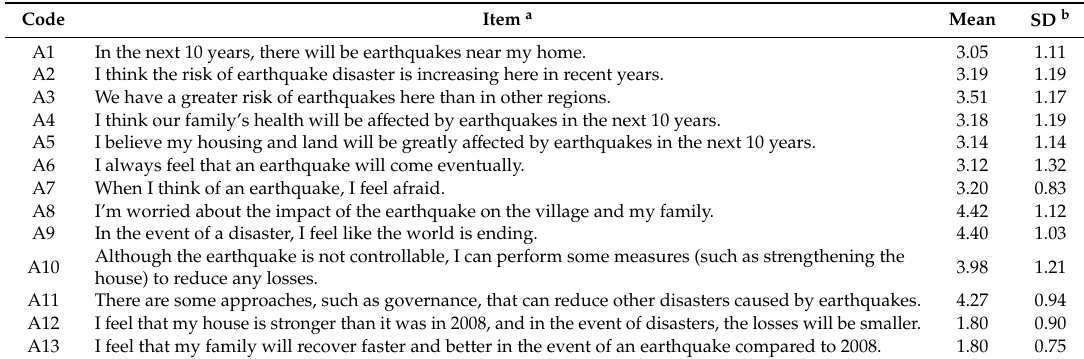
Table 1. Risk perception